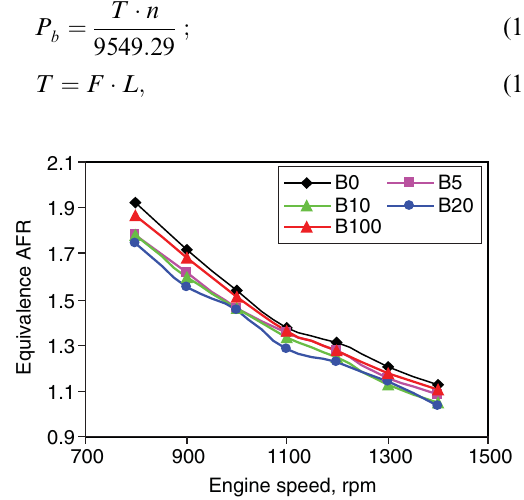
Fig. 5. The effect of tested fuels on equivalence air fuel ratio at different engine